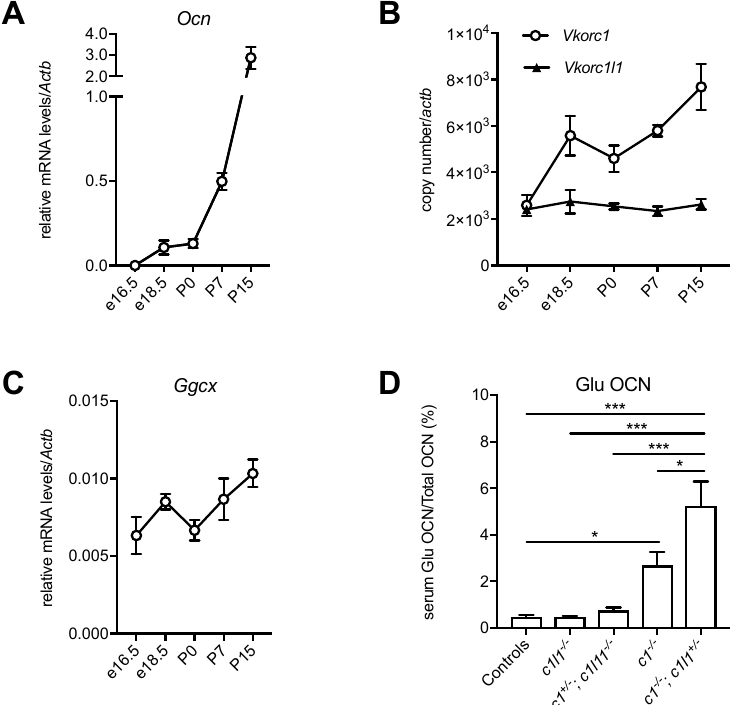
Figure 4. Developmental regulation of the vitamin K cycle in bones. ( A – C ) Calvaria from e16.5, e18.5, P0, P7 and P15 C57BL/6J mice were harvested, and the total RNA was extracted (mean ± standard error of the mean (SEM), n = 3). ( A ) Relative mRNA levels of the gene encoding osteocalcin ( Ocn ) were measured by quantitative PCR (qPCR) and normalized to the actin ‐β gene Actb . ( B ) Vkorc1 and Vkorc1l1 gene expressions were measured by qPCR and normalized to Actb . The copy number was quantified using plasmid DNA, containing either Vkorc1 or Vkorc1l1 cDNA as a standard. ( C ) Relative mRNA levels of Ggcx were measured by qPCR and normalized to Actb . ( D ) Decarboxylated osteocalcin (Glu OCN) and total osteocalcin (total OCN) serum levels were measured in newborn mice (P0), for the indicated genotypes ( c1 : Vkorc1 ; c1l1 : Vkorc1l1 ), using previously described assays [59] and the level of Glu OCN, expressed as a percentage of total OCN (mean ± standard error of the mean (SEM), n = 4–18, * p < 0.05, *** p <